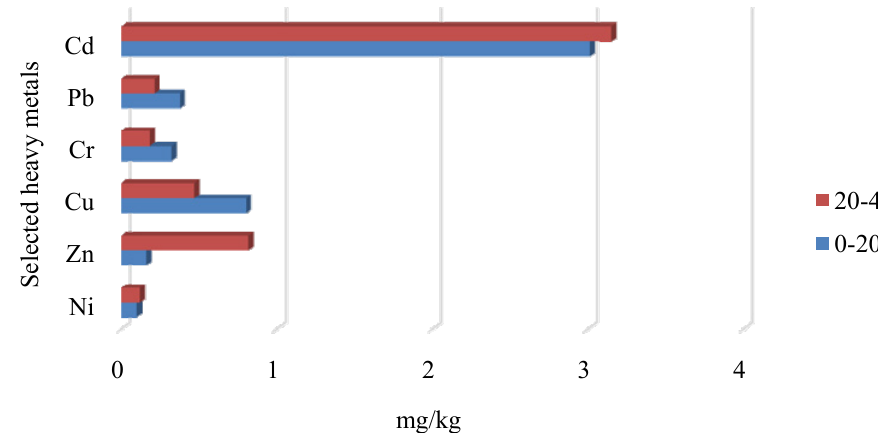
Fig. 4: Contamination factor (CF) for soil samples at various depths